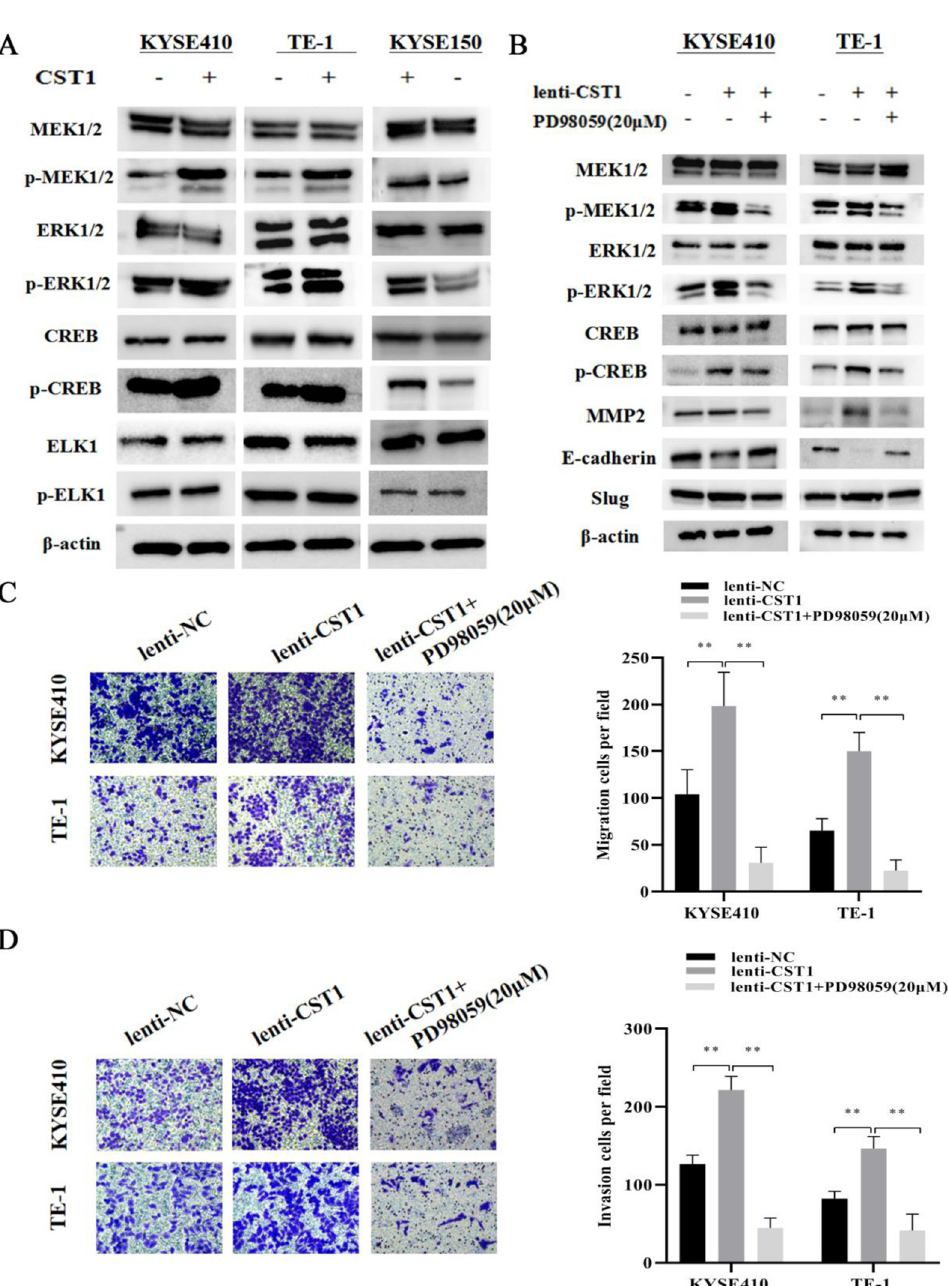
Fig 5. Effect of CST1 on MEK/ERK/CREB pathway. (A) Changes in MEK/ERK/CREB pathway proteins. (B) Changes in MEK/ERK/CREB pathway and EMT-related proteins after the addition of inhibitor PD98059 (20 μ M). (C) Changes in cell migration ability after the addition of inhibitor PD98059 ( × 200). (D) Changes in cell invasion ability after the addition of inhibitor PD98059 ( × 200). ( �� P < 0.01). whereas the expression of E-cadherin was upregulated (Fig 5B). Transwell assay results showed that the addition of PD98059 (20 μ M) inhibited the ability of CST1 to promote the migration and invasion of ESCC cells (Fig 5C and 5D). These results indicated that CST1 might promote ESCC migration and invasion by MEK/ERK/CREB pathway.